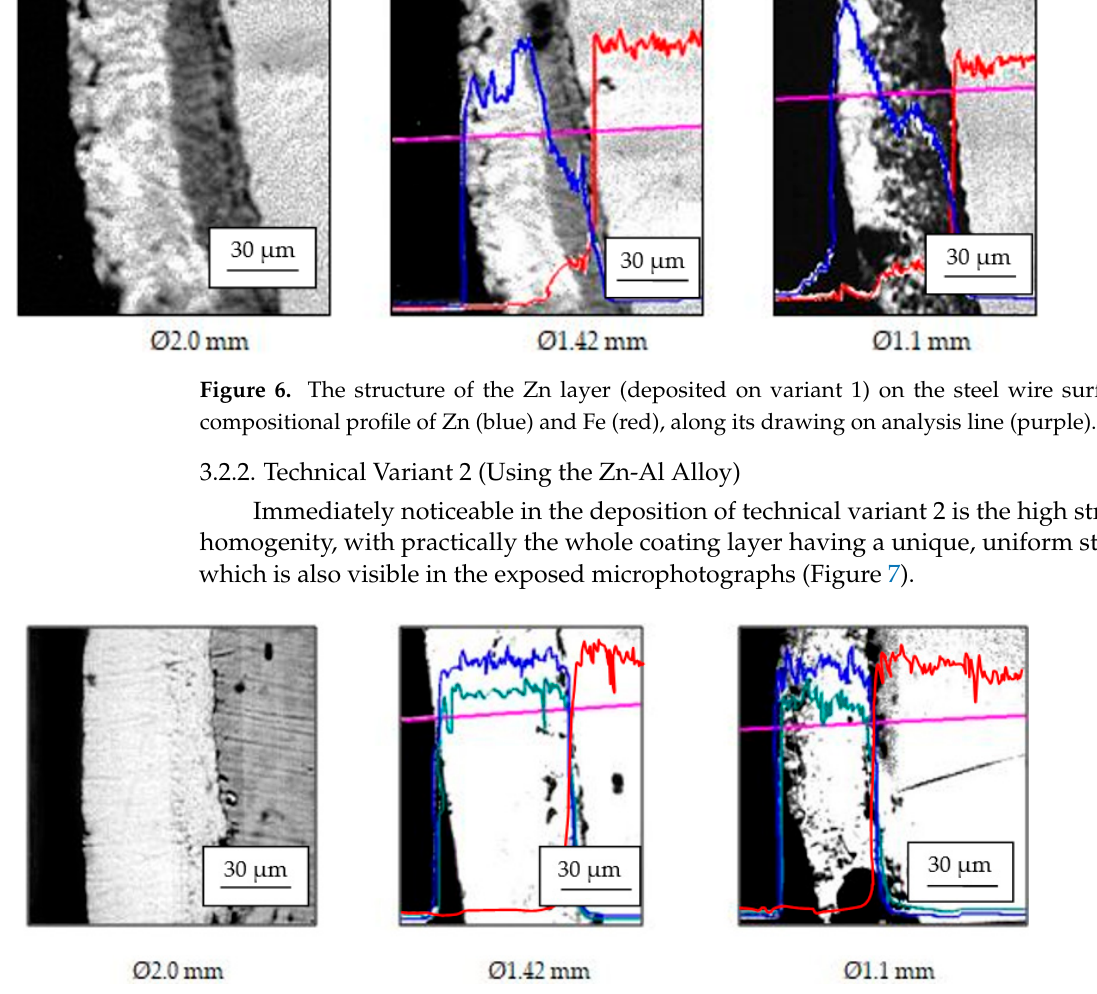
Figure 5. The structure of the Zn layer, “Hot Dip”, deposited on the steel wire surface.